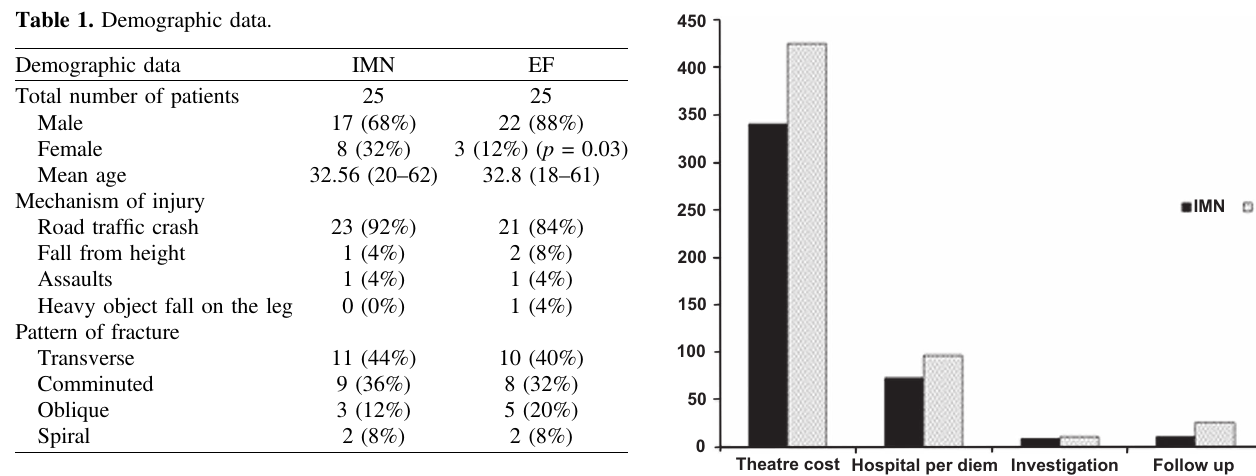
Figure 1. Mean total theater cost, hospital per diem, investigation and follow-up costs in the IMN and EF groups.